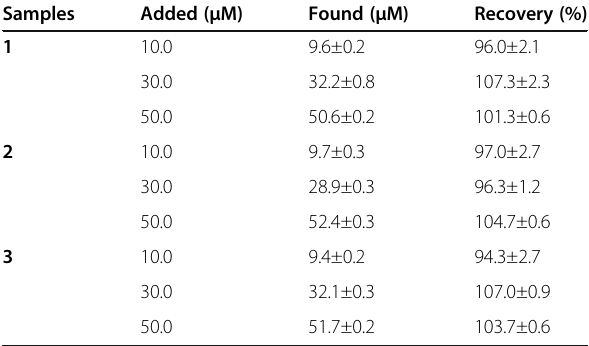
Table 1 Recovery of FA obtained from the human urine samples ( n =6) Samples Added ( μ